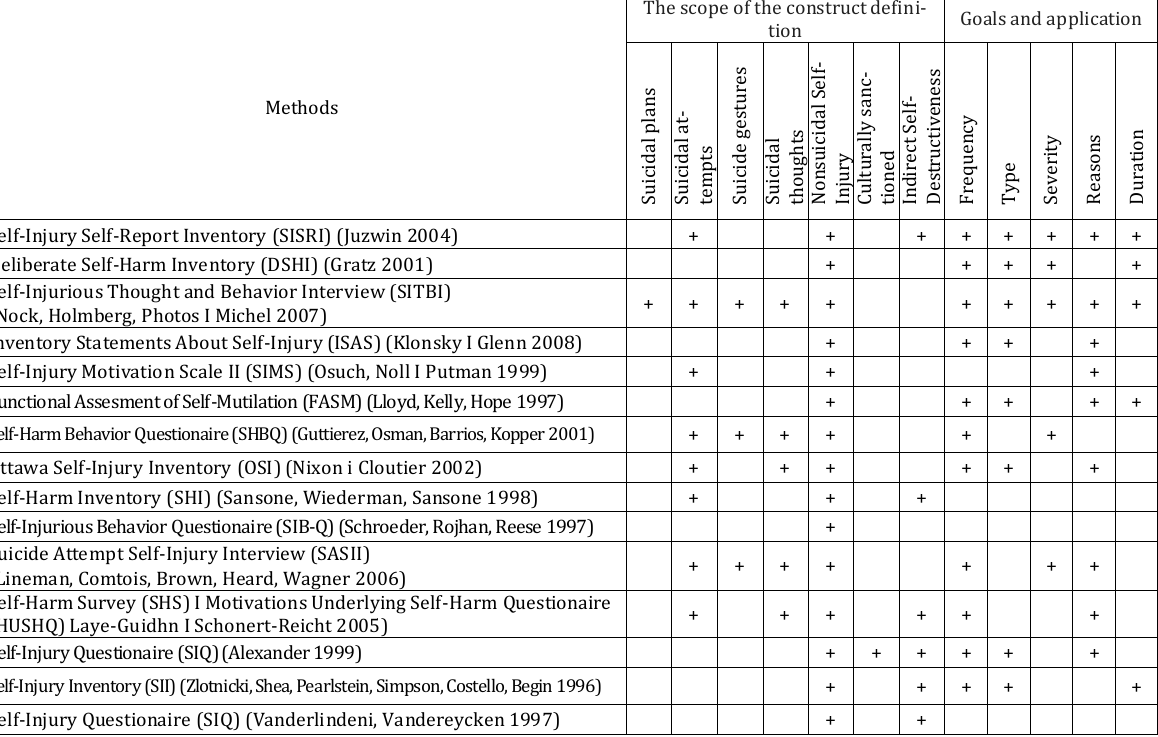
Table 1, developed by Kubiak [51] presents the scope of the studies of various aspects of NSSI at selected scales was compared (published with authors